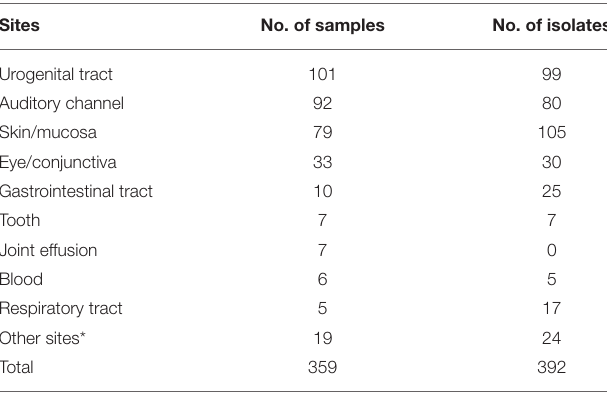
TABLE 1 | Distribution of sampling sites and